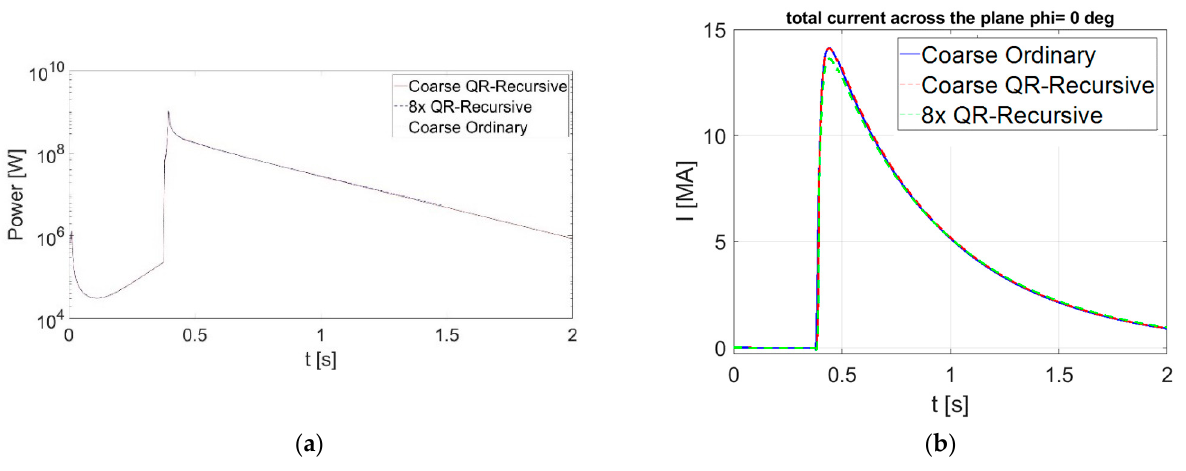
Figure 18. Testcase#2. The overall ohmic loss ( a ) and the total toroidal current ( b ) versus time.